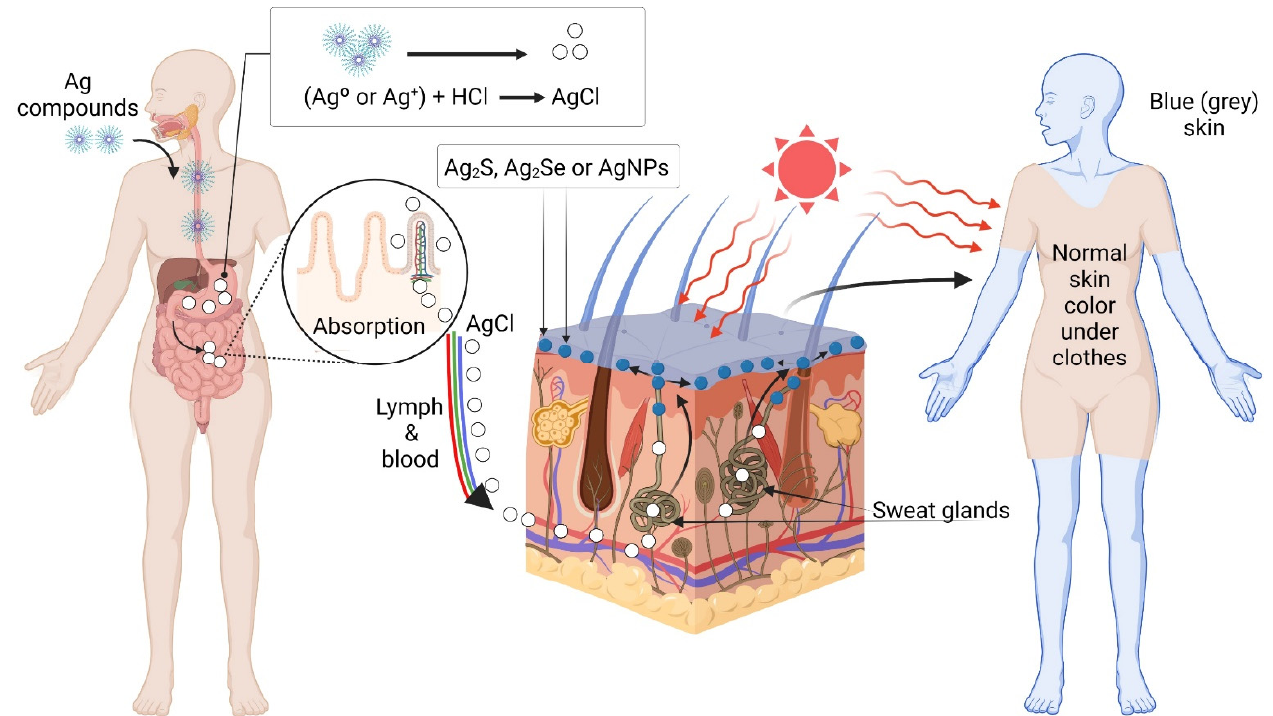
Figure 6. Scheme of a hypothetical process of delivering the silver compounds from the gastrointestinal tract to the skin for argyria. Created with BioRender.com (accessed on 7 April 2022).